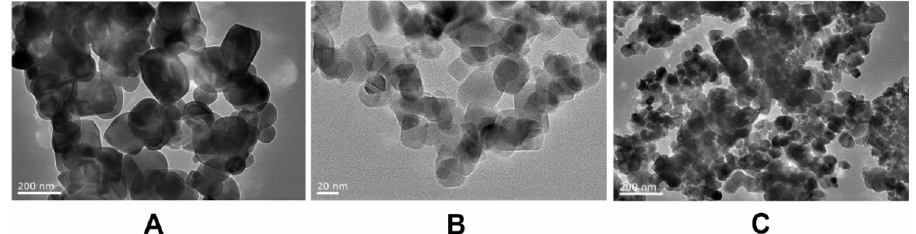
Figure 1. TEM Characterization of bulk TiO 2 (A) and TiO 2 NPs (B, C). TiO 2 NPs exhibited good monodispersity and showed approximately normal distribution.